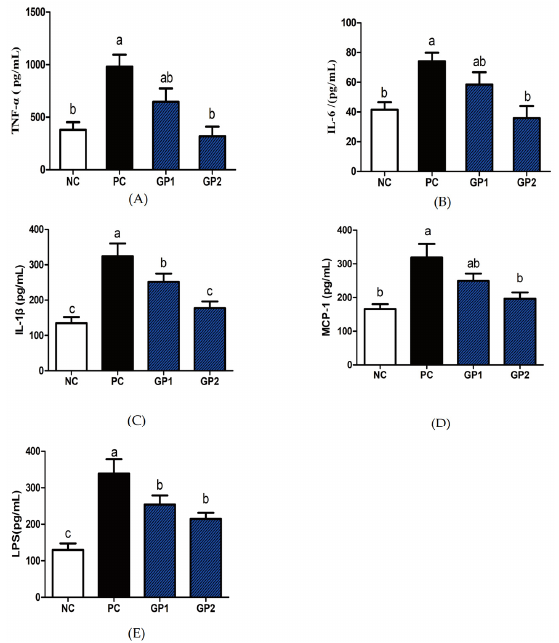
Figure 5. GP reduced inflammatory cytokines secretion in serum of DSS-colitis mice. The levels of TNF- α ( A ), IL-6 ( B ), IL-1 β ( C ), MCP-1 ( D ), LPS ( E ) in serum were determined by ELISA. All values represent the means ± SD ( n = 8). According to the one-way ANOVA (Tukey’s Multiple Comparison Test), the different letters mean significant differences of p < 0.05.